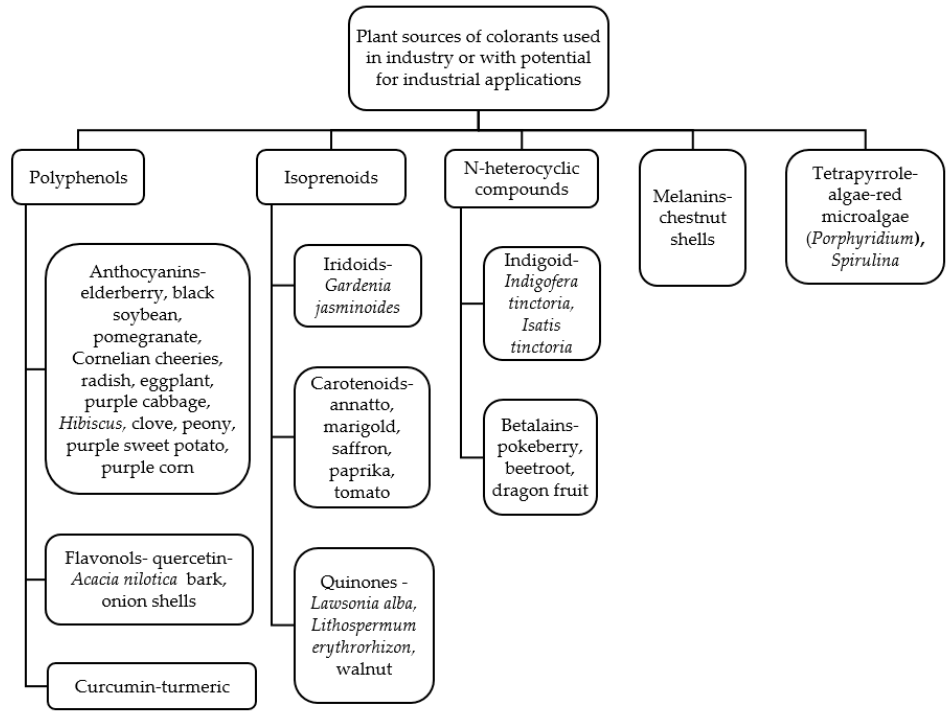
Figure 2. Plant sources of colorants used in the food, textile or cosmetic industries or with potential for food, textile or cosmetic industry applications.